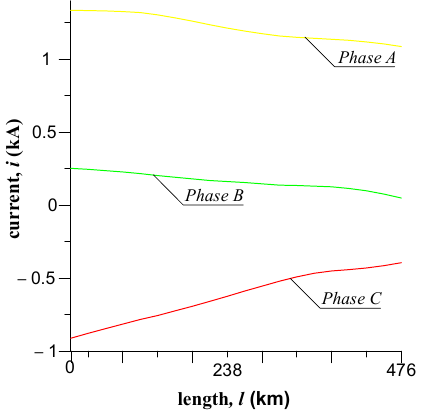
Figure 5. The phase current across the line as a function of distance at t = 0.005 s. We can see that at t = 0.005 s, the phase A current at the line’s beginning is 1.7 kA, diminishing gradually along the line until reaching 1.2 kA at its end. Since phase B is not yet on at t = 0.005 s, the phase B current is induced from phases A and C and is nearly linear; it is up to 250 A at the line’s beginning and almost zero at its end. The phase C current at the line’s beginning is − 800 A and − 300 A at its end. The phase voltage across the line as a function of distance at t = 0.01 s from the time of the voltage turn-on is depicted in Figure 6.